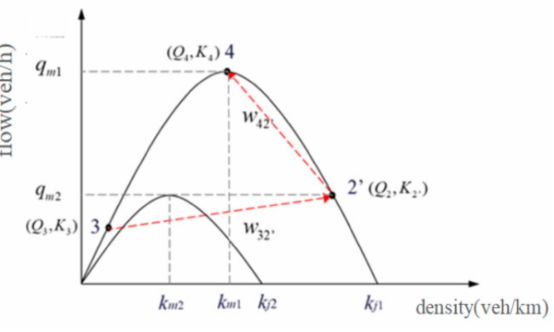
Figure 8. Diagram of flow–density after traffic accident clearance in the extra-long tunnel.